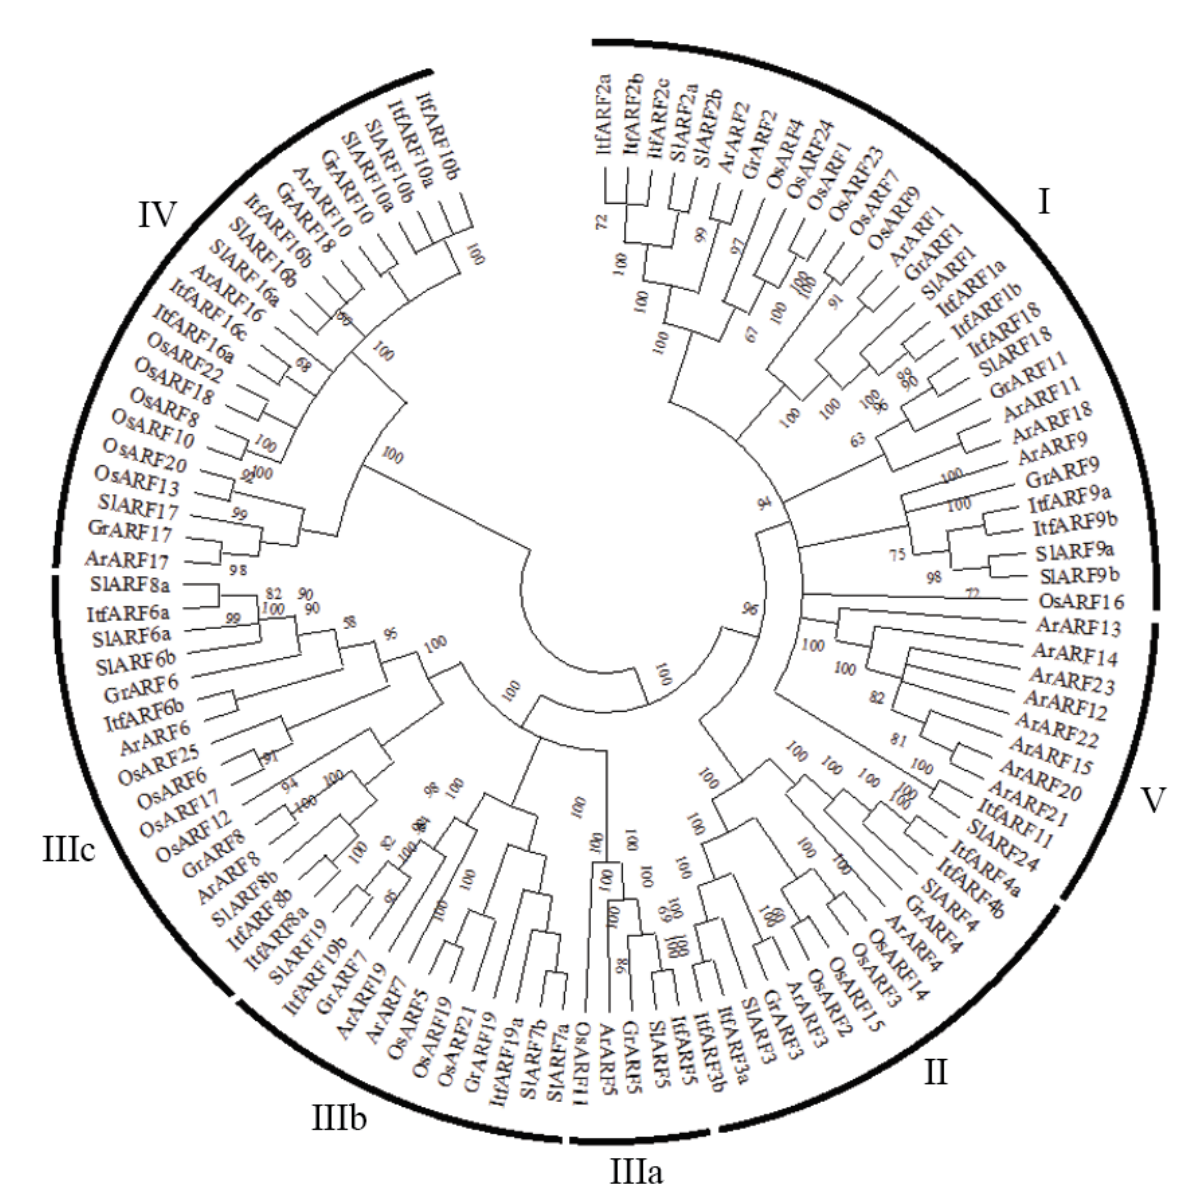
Figure 1. Phylogenetic tree comprised of ARF proteins found in Arabidopsis , cotton, I. trifida , tomato, and rice. This tree was constructed using MEGA-X software using the maximum-likelihood method with the JTT model. The parameters were 1000 bootstraps and pairwise gap deletions. The 109 ARF proteins were classified into five classes: I , II , III , IV , and V , and class III was further divided into IIIa , IIIb , and IIIc .